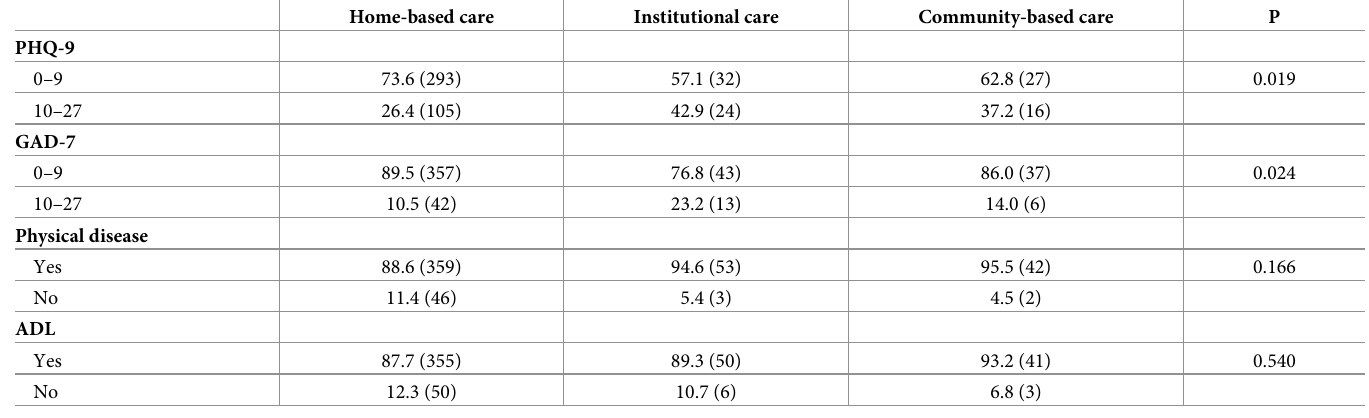
Table 2. Depression, anxiety and physical disease among the elderly.